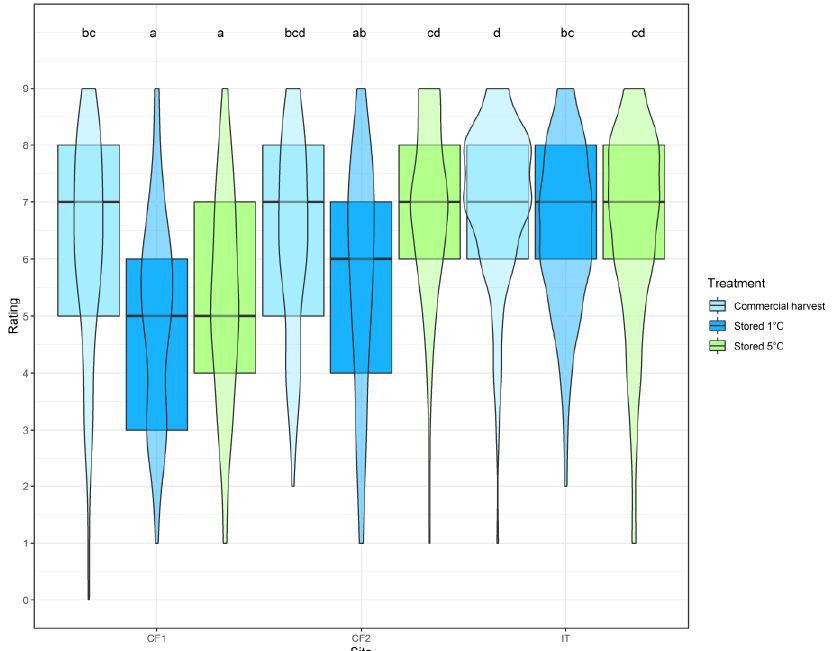
Figure 3. Hedonic responses to three samples of ‘Big Top’ peach stored under different conditions tasted at three locations (Italy and UK). Participants were asked to rate peaches on a 9-point scale. Boxplots show the median and quartiles for each group, while the violin plots indicate the proportion of data points at each value. Letters indicate significant differences.